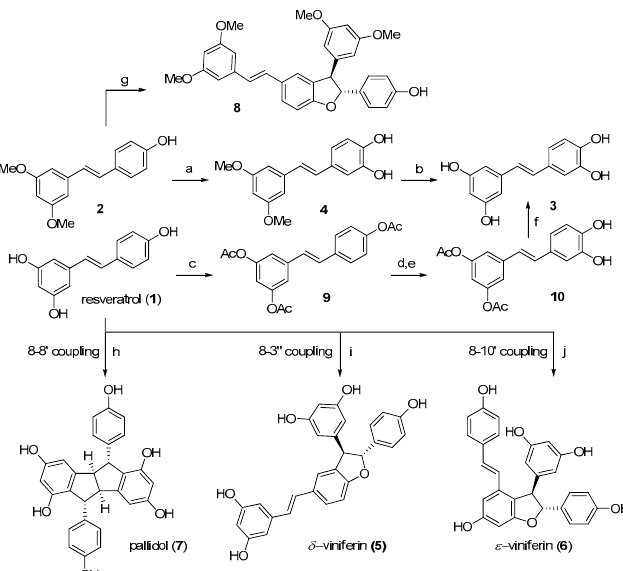
Figure 2. Synthesis of monomers 3 – 4 and dimers 5 – 8 . Reagents and conditions: a) 1-IBX, DMF, r.t., 80 min; 2-NaBH 4 MeOH 0 °C, 62%; b) BBr 3 , DCM, − 35 °C to r.t., N 2 , 22 h, 20%; c) Ac 2 O, TEA, DCM, r.t., overnight, 92%; d) CAL-B ( Candida antarctica lipase), toluene/n-BuOH, 40 °C, 6 h, 81%; e) IBX, DMF, r.t., 80 min, 42%; f) NH 2 NH 2 , MeOH, r.t., 30 min, 81%; g) 1-HRP, 30 min, 40 °C, acetone: Citrate buffer pH 5 (1:1); 2-H 2 O 2 , 15 min, 40 ◦ C, overall yield 61%; h) 1-HRP, 30 min, 40 ◦ C, acetone: Phosphate bu ff er pH 8 (1:1); 2-H 2 O 2 , 90 min, 40 ◦ C, overall yield 21%; i) 1 - HRP, 30 min, 40 ◦ C, acetone: Citrate bu ff er pH 5 (1:1); 2-H 2 O 2 , 90 min, 40 ◦ C, overall yield 49%; j) FeCl 3 6H 2 O, MeOH : H 2 O 1:1,